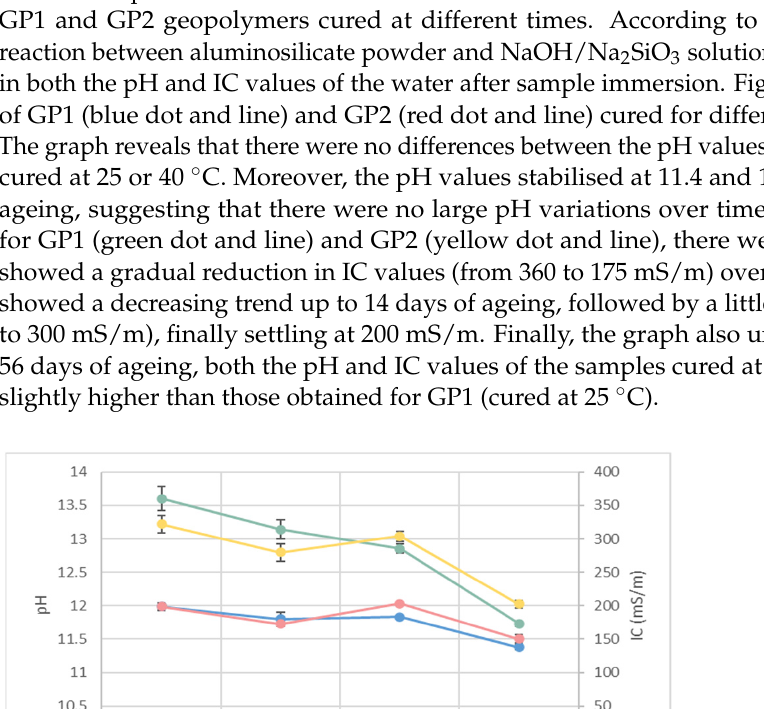
1 h in water at different ageing times.